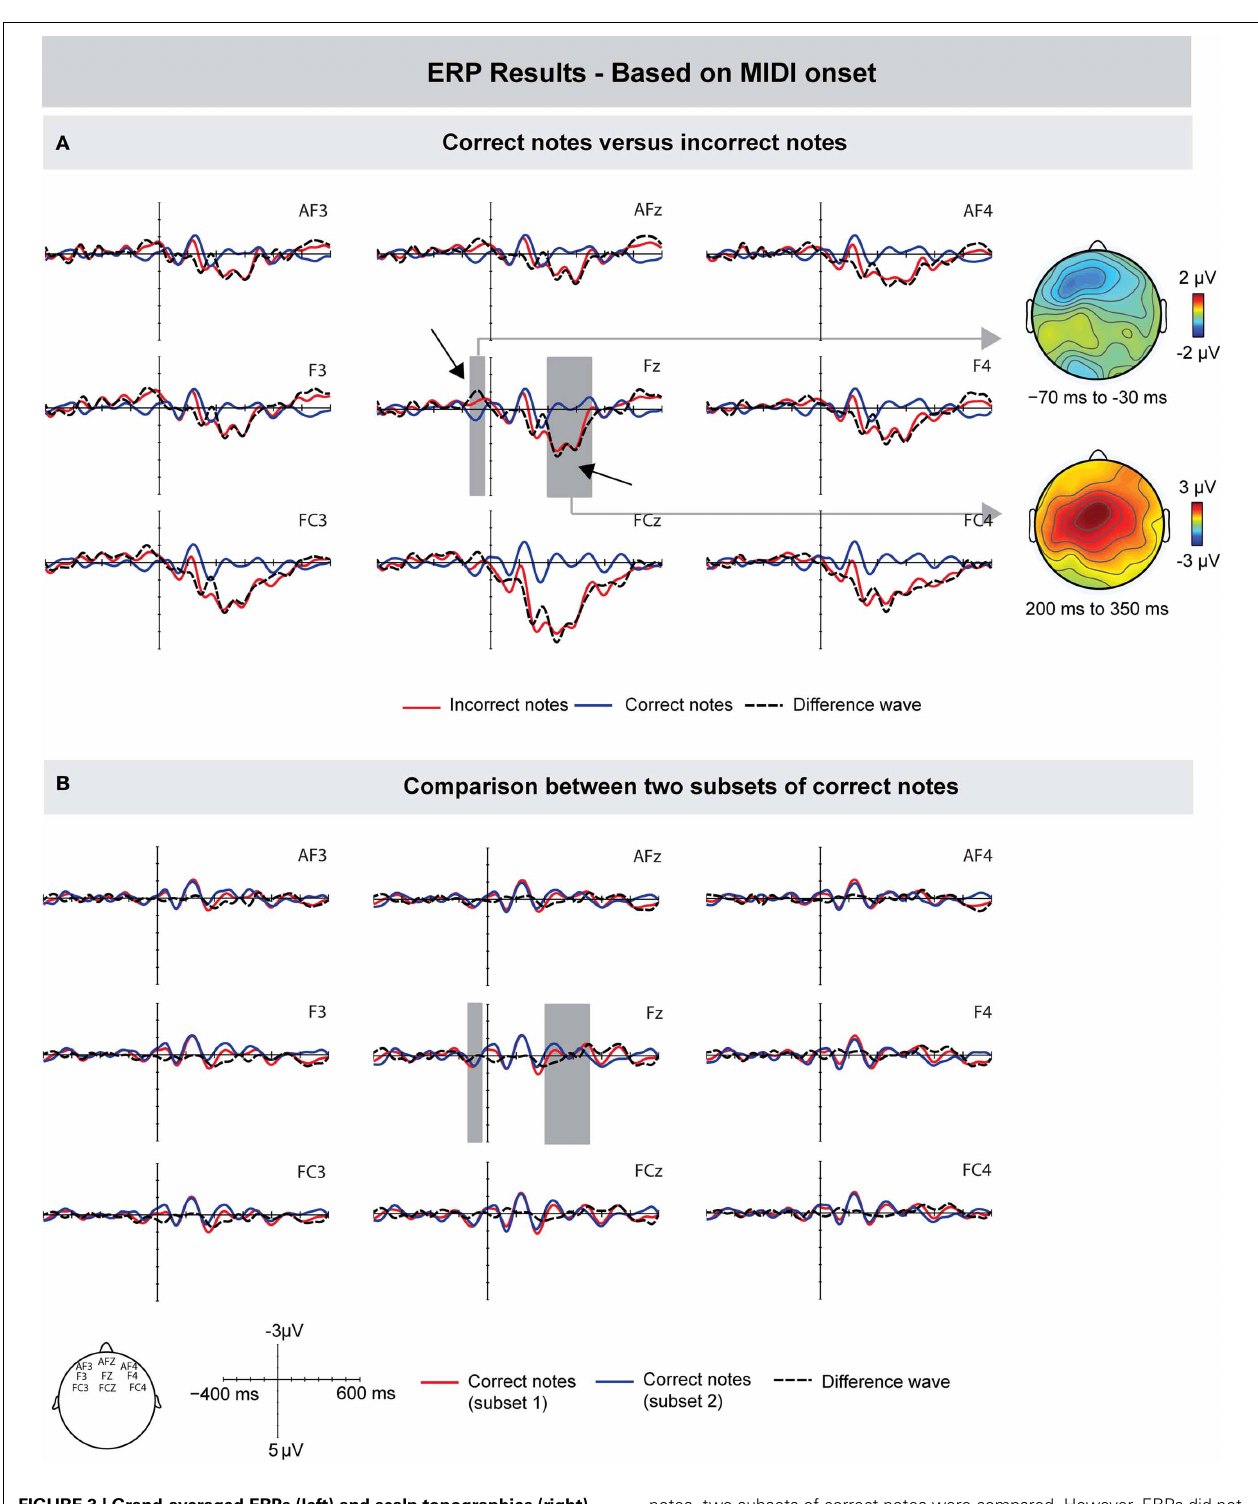
FIGURE 3 | Grand-averaged ERPs (left) and scalp topographies (right) based on the MIDI data. (A) Compared to correctly produced keystrokes, incorrectly produced keystrokes elicited a pre-error negativity around 50ms prior to MIDI onset, and an Error Positivity (Pe) around 250ms after MIDI onset. (B) To investigate whether the difference between correct and incorrect notes is influenced by overlapping ERP responses from